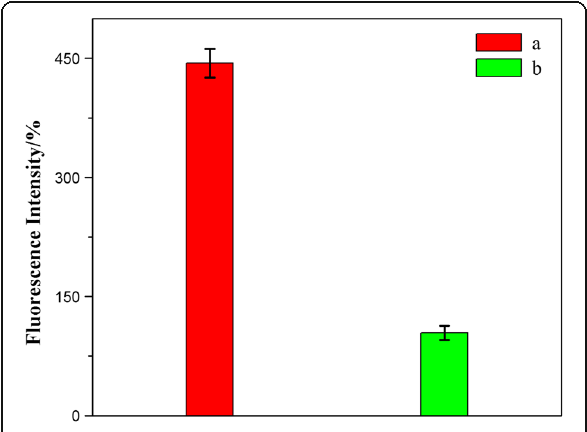
Fig. 9 Fluorescence measurements of the HeLa cells incubated with HFNDs ( a ) and NDs ( b ) over an 8-h incubation period at 37 °C; P <0.05